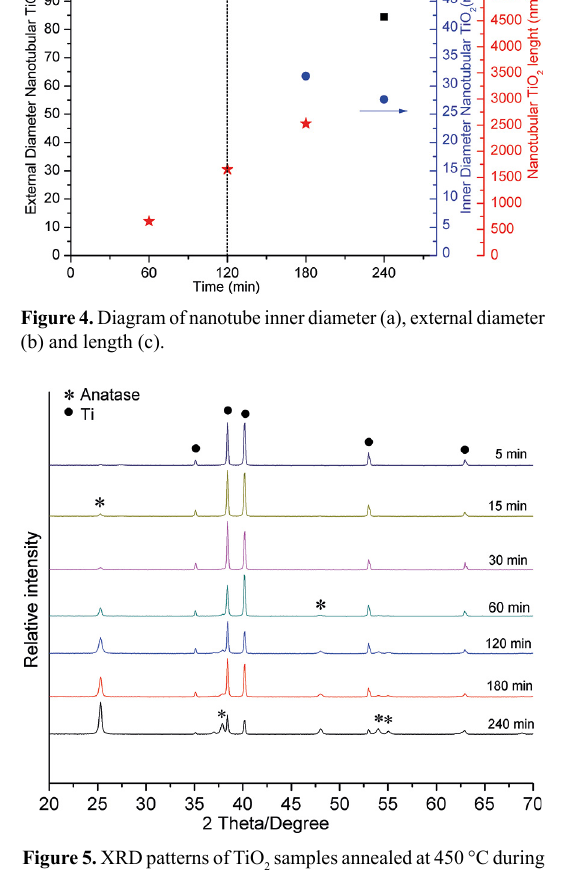
Figure 5. XRD patterns of TiO 3 h with a heating and cooling rate of 10 °C min -1 .